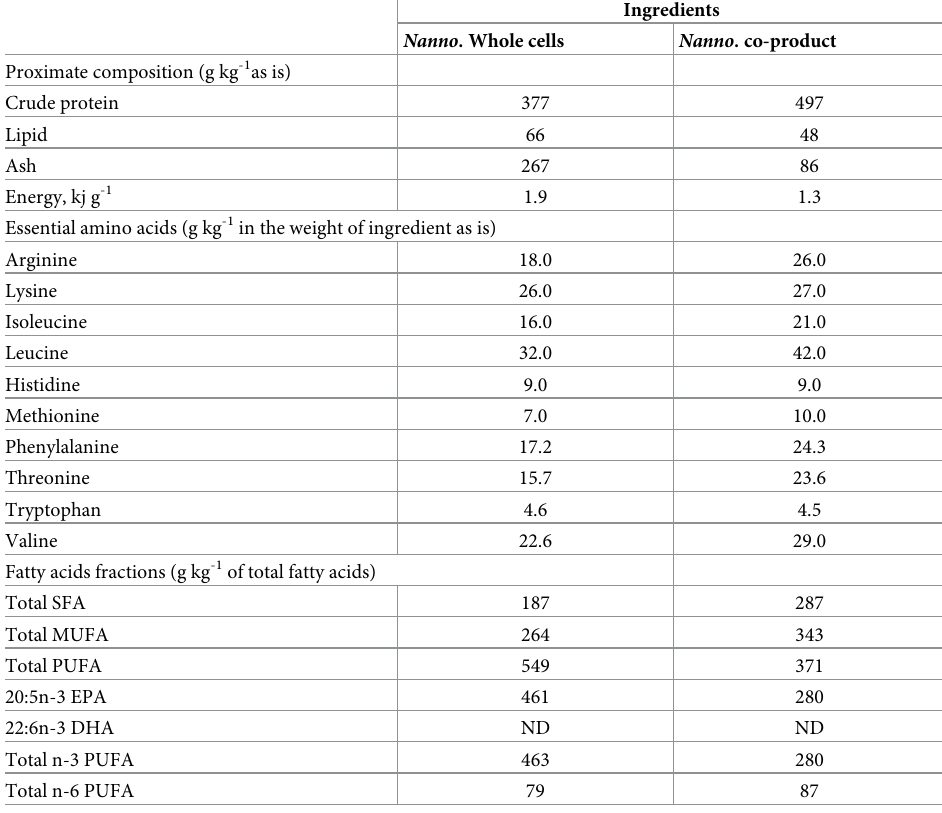
Table 2. Proximate chemical composition, gross energy, essential amino acid and fatty acid profiles of the N . ocu- lata whole cells and N . oculata co-product as test ingredients. Ingredients Nanno . Whole cells Nanno . co-product Proximate composition (g kg -1 as is) Crude protein 377 497 Lipid 66 48 Ash 267 86 Energy, kj g -1 1.9 1.3 Essential amino acids (g kg -1 in the weight of ingredient as is) Arginine 18.0 26.0 Lysine 26.0 27.0 Isoleucine 16.0 21.0 Leucine 32.0 42.0 Histidine 9.0 9.0 Methionine 7.0 10.0 Phenylalanine 17.2 24.3 Threonine 15.7 23.6 Tryptophan 4.6 4.5 Valine 22.6 29.0 Fatty acids fractions (g kg -1 of total fatty acids) Total SFA 187 287 Total MUFA 264 343 Total PUFA 549 371 20:5n-3 EPA 461 280 22:6n-3 DHA ND ND Total n-3 PUFA 463 280 Total n-6 PUFA 79 87 SFA, saturated fatty acids; MUFA, monounsaturated fatty acids; PUFA, polyunsaturated fatty acids; EPA, eicosapentaenoic acid; DHA, docosahexaenoic